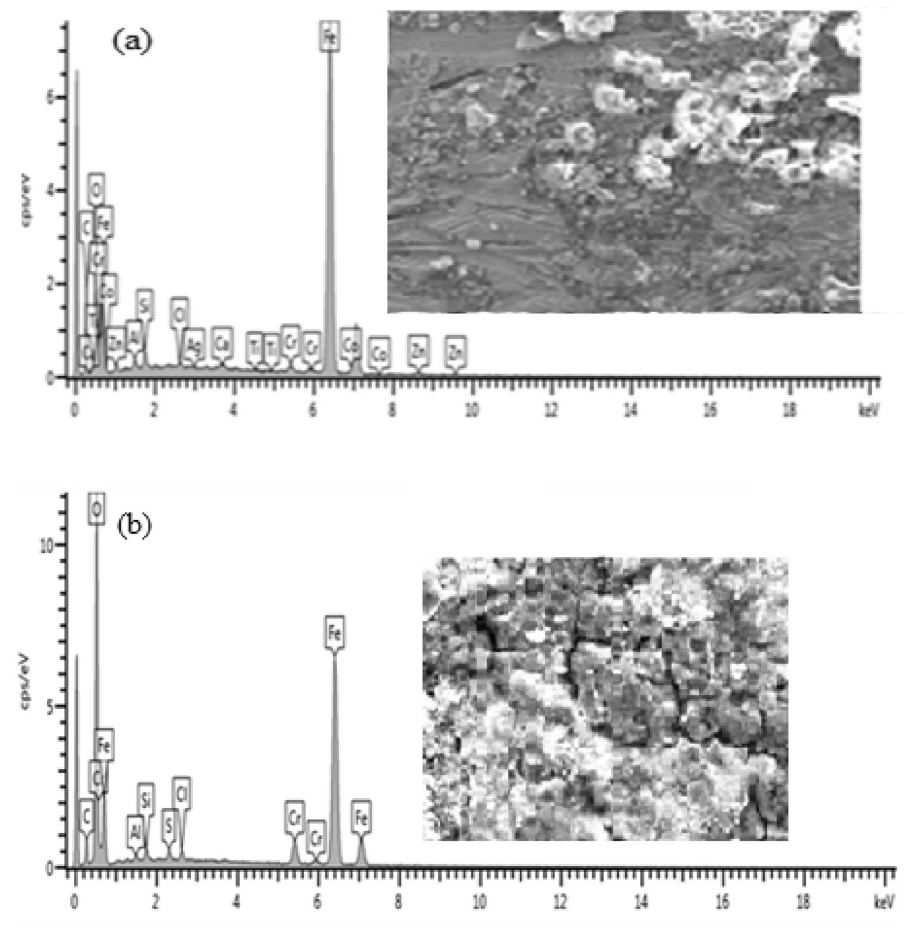
Figure 7. Energy diffraction spectron (EDS) of As-received sample: ( a ) before corrosion and ( b ) after corrosion.